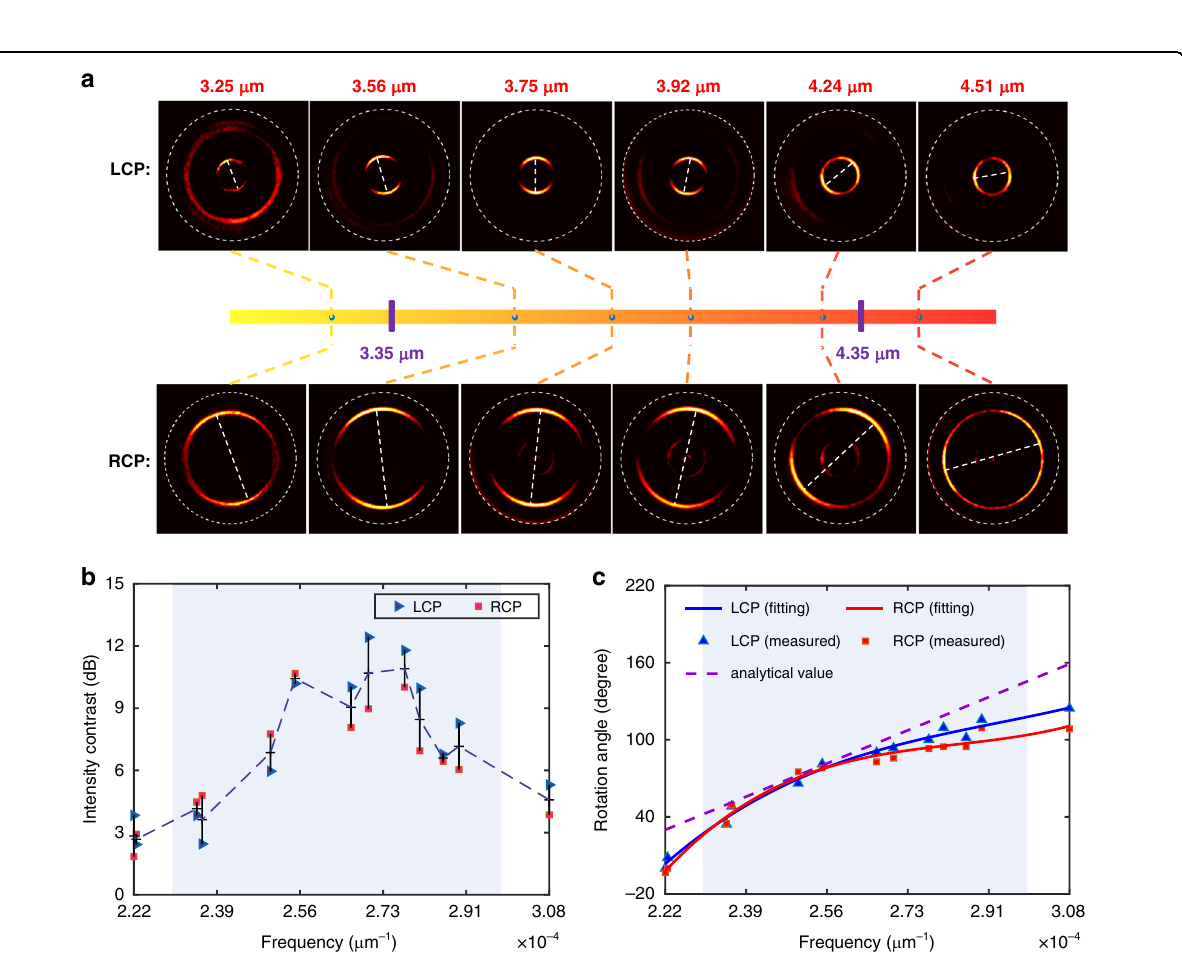
Fig. 4 Simultaneous characterization of frequency and polarization state. a The captured images on the focal plane at different frequencies under left and right circular polarization incidence. The inner and outer rings are respectively lightened as a function of the incident polarization state. b Intensity contrasts of the measured results at different frequencies. The values are on a logarithmic scale. The blue points represent the cases under the left circular polarization and the red ones for the right circular polarization state. c Relationship between the rotation angle of interfered spots and the incident frequency. The dashed purple line represents the analytical values. The blue background in ( b ) and ( c ) represents the designed operation bandwidth. LCP: left-handed circular polarization, RCP: right-handed circular